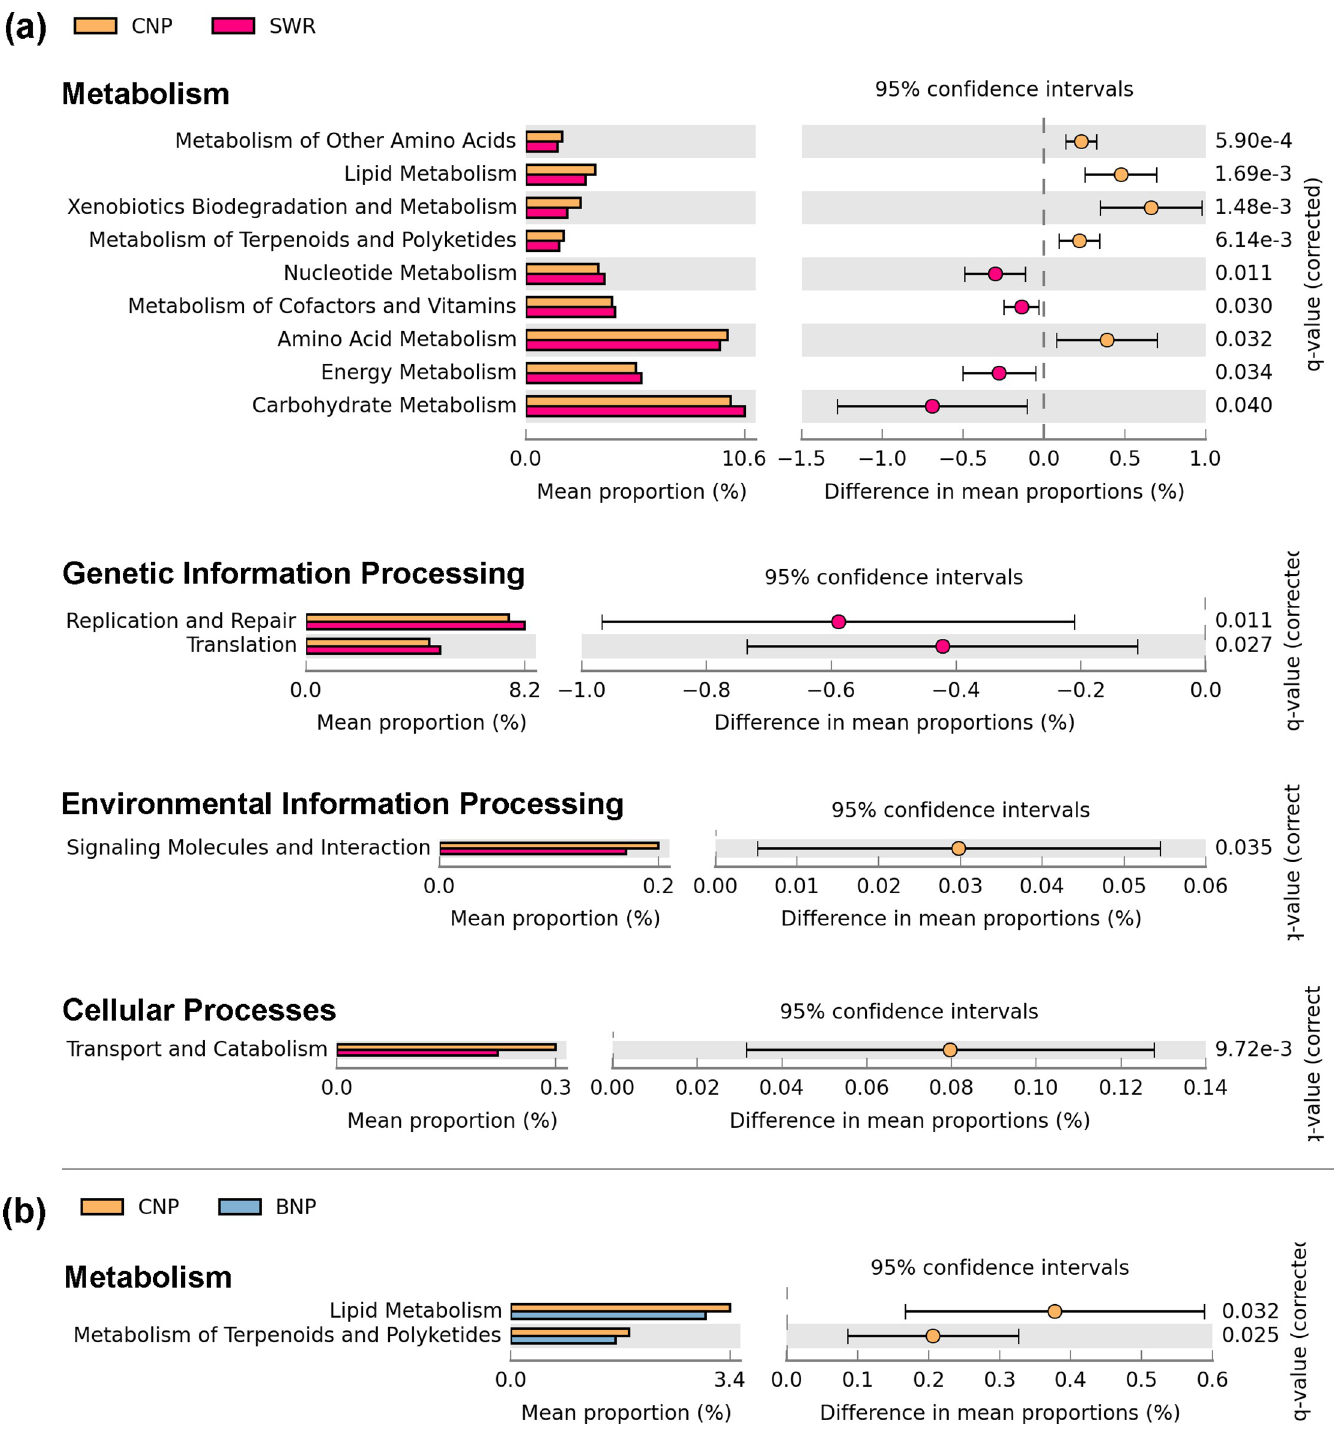
Fig 7. Mean proportions of predictive metabolic functional categories between tiger populations based on pair-wise comparison- functional categories are more diverse between CNP and SWR than CNP and BNP. (a) Significant functional categories identified between CNP and SWR. (b) Significant functional categories identified between CNP and